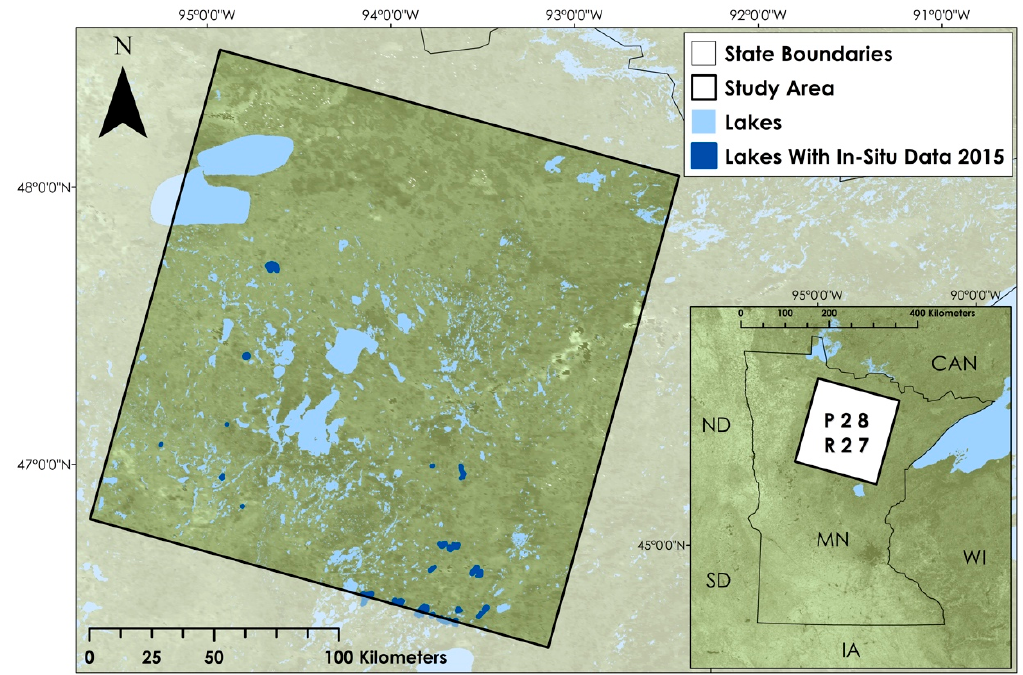
Figure 3. Study area extent in north-central Minnesota, USA (Landsat Path 28, Row 27).